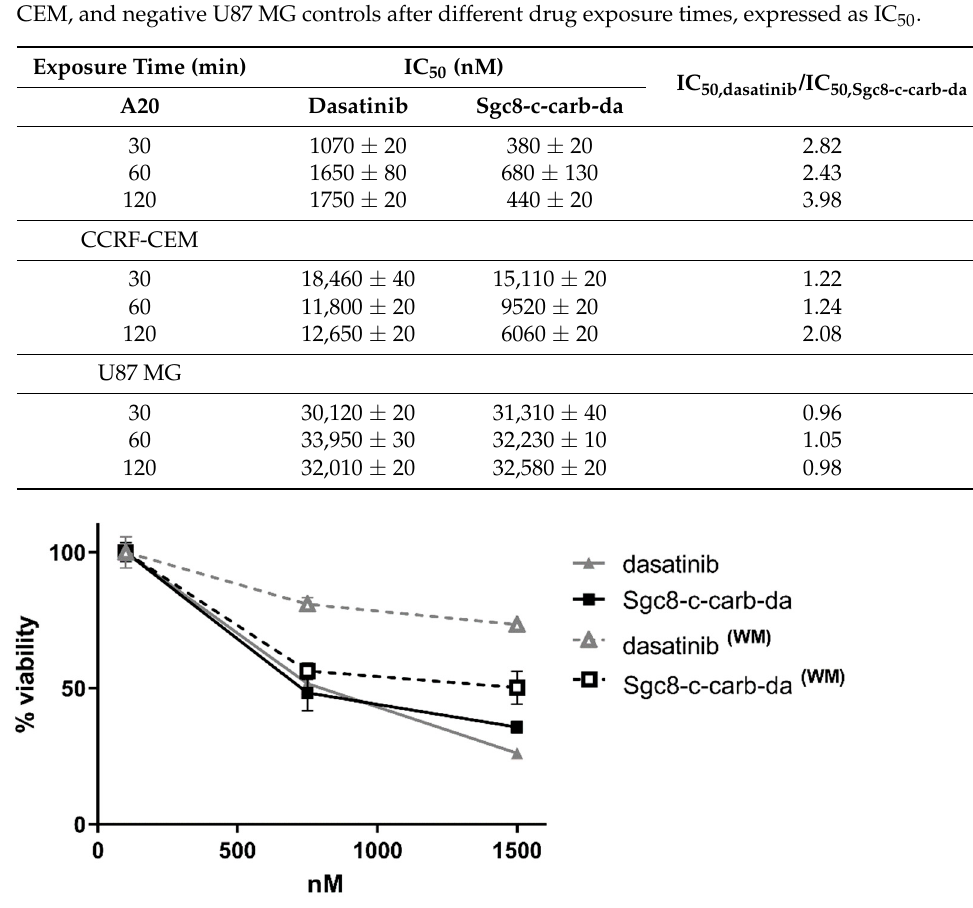
Figure 3. Evaluation of Sgc8-c-carb-da binding via PTK7 in A20 cells. Dose-response curves for dasatinib or Sgc8-c-carb-da after 48 h of incubation with A20 cells, with (WM) or without the washing method (60 min of drug exposure followed by a wash and further incubation). Cytotoxicity was evaluated by MTT. Graph shows mean ± SD, n = 10 per condition.